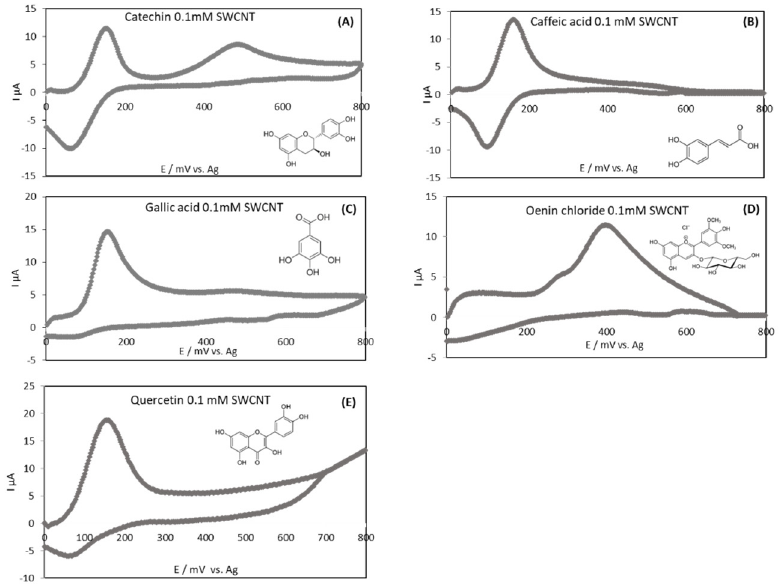
Figure 2. Cyclic voltammograms of different standard polyphenols at SWCNT-SCPE: catechin ( A ); caffeic acid ( B ); gallic acid ( C ); oenin chloride ( D ) and quercetin ( E ) at a concentration of 0.1 mM (blank subtracted); SWCNT-SPCE: single walled carbon nanotubes modified screen printed carbon electrodes. Table 3. Voltammetric peak potentials of the standard polyphenols (concentration of 0.1 mM) in model wine solution (pH 3.6) using SWCNT-SPCE. Ep,a 1 represents the potential of the first anodic peak and Ep,a 2 represents the potential of the second anodic peak.